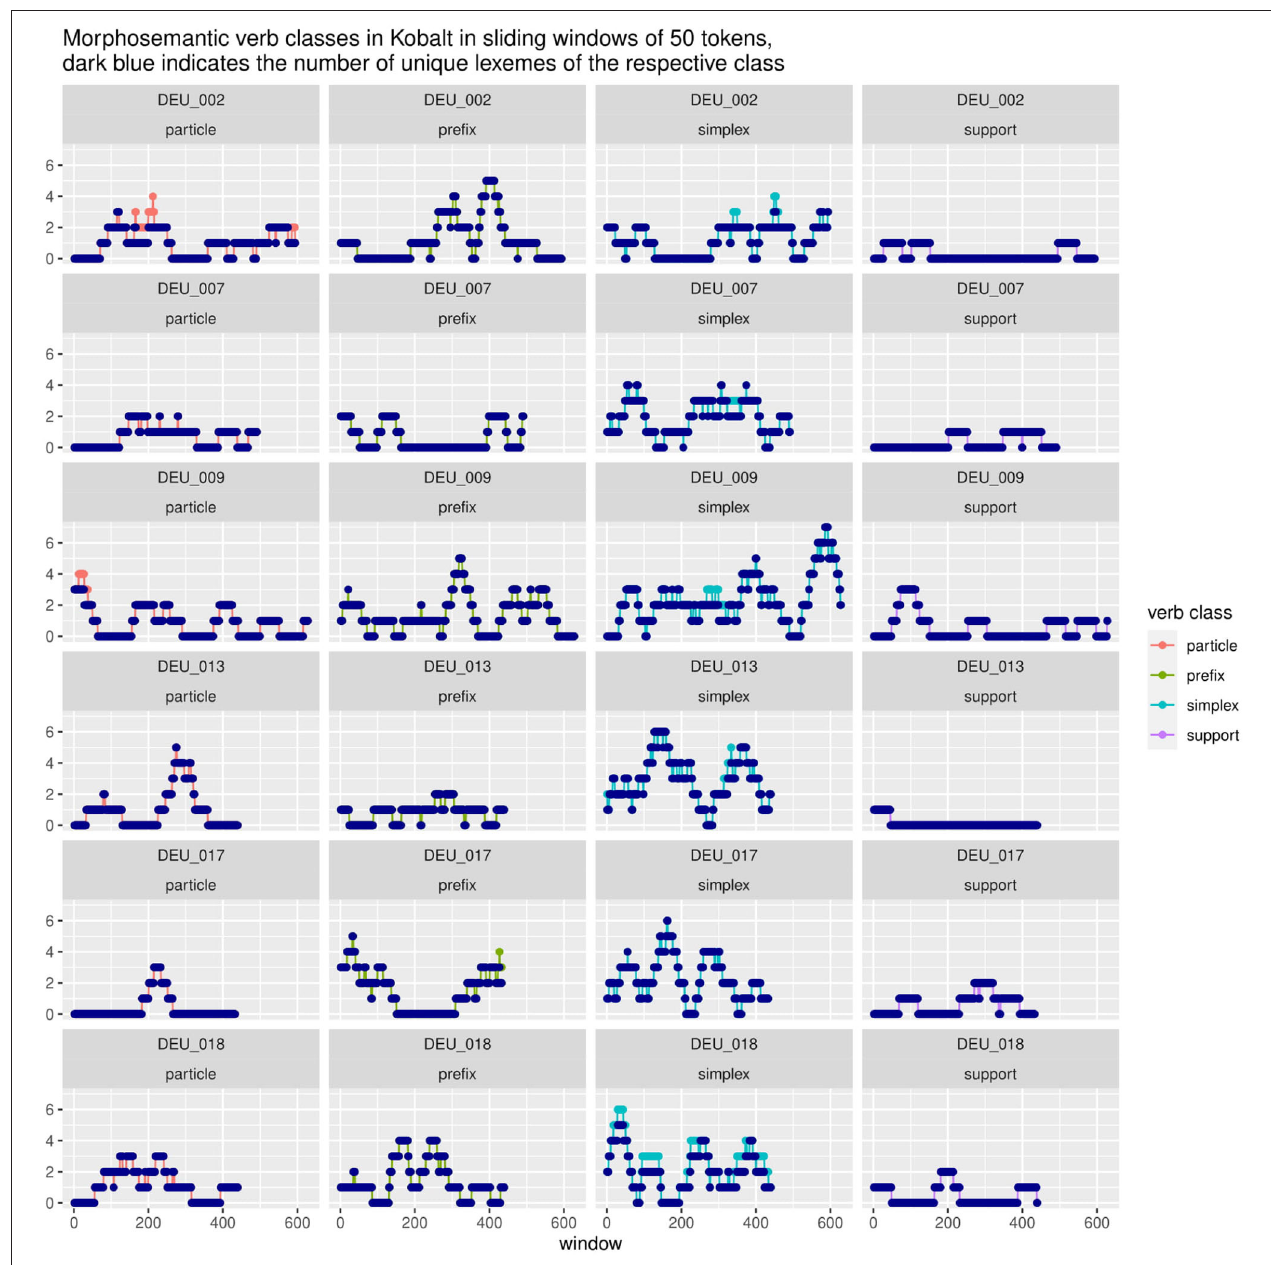
FIGURE 11 | Strong clustering effects can be seen for prefix (DEU_002, DEU_009, DEU_017) and particle verbs (DEU_013, DEU_017). However, not all speakers exhibit those to the same degree (DEU_007). Lexeme repetition or α -priming does not appear to play a significant